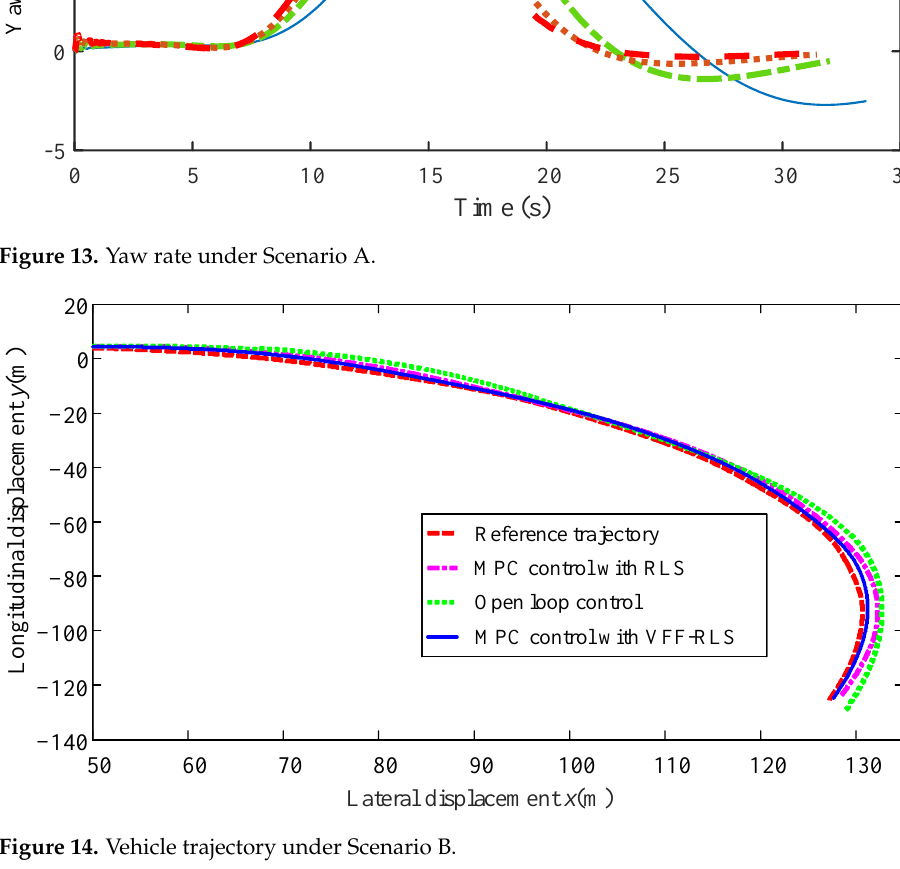
Figure 14. Vehicle trajectory under Scenario B.